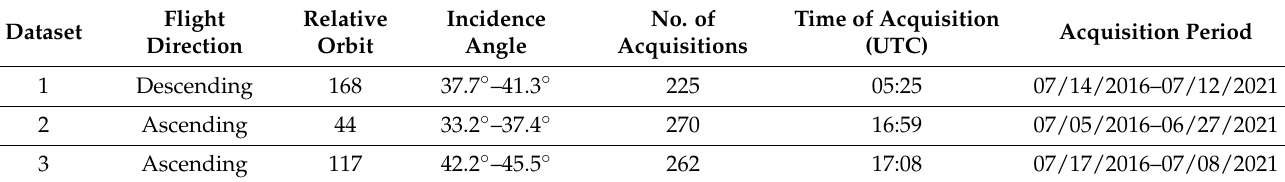
Figure 2. Overview of the backscatter behavior of AOI “Burkersdorf” depending on polarization and pass direction for only coniferous forested area with precipitation (grey) and temperature (yellow) (y-axis combined for precipitation and average temperature). The thick lines show the filtered time series using a simple moving average filter with a window size of 10 (corresponds to 2 months in the time series). Table 1. Acquisition parameters for the Sentinel 1 datasets: